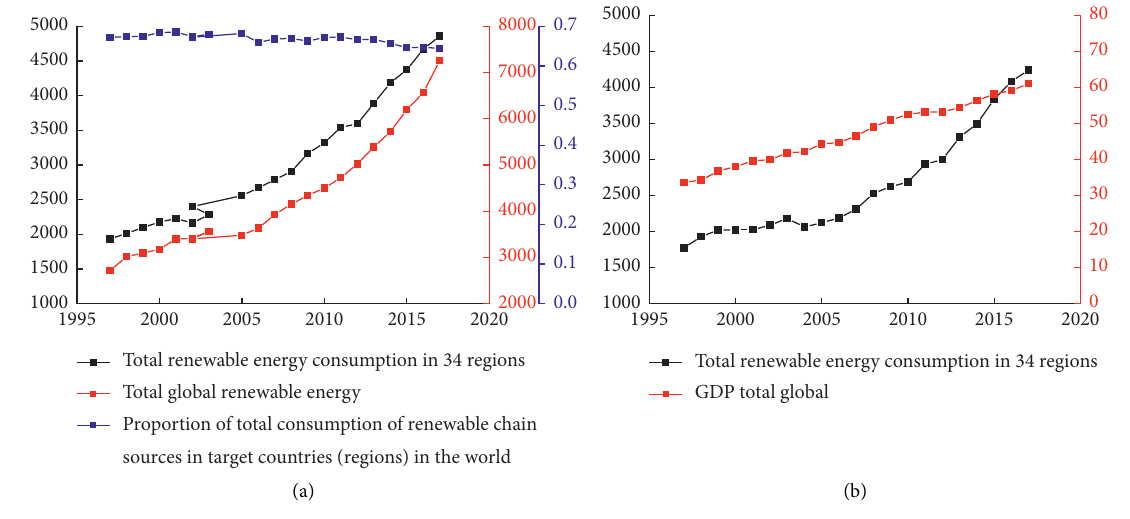
Figure 5: Relationship of total renewable energy consumption. (a) Total renewable energy consumption and global share in 34 target countries (regions) and (b) total renewable energy consumption and total real GDP in 34 target countries (regions).